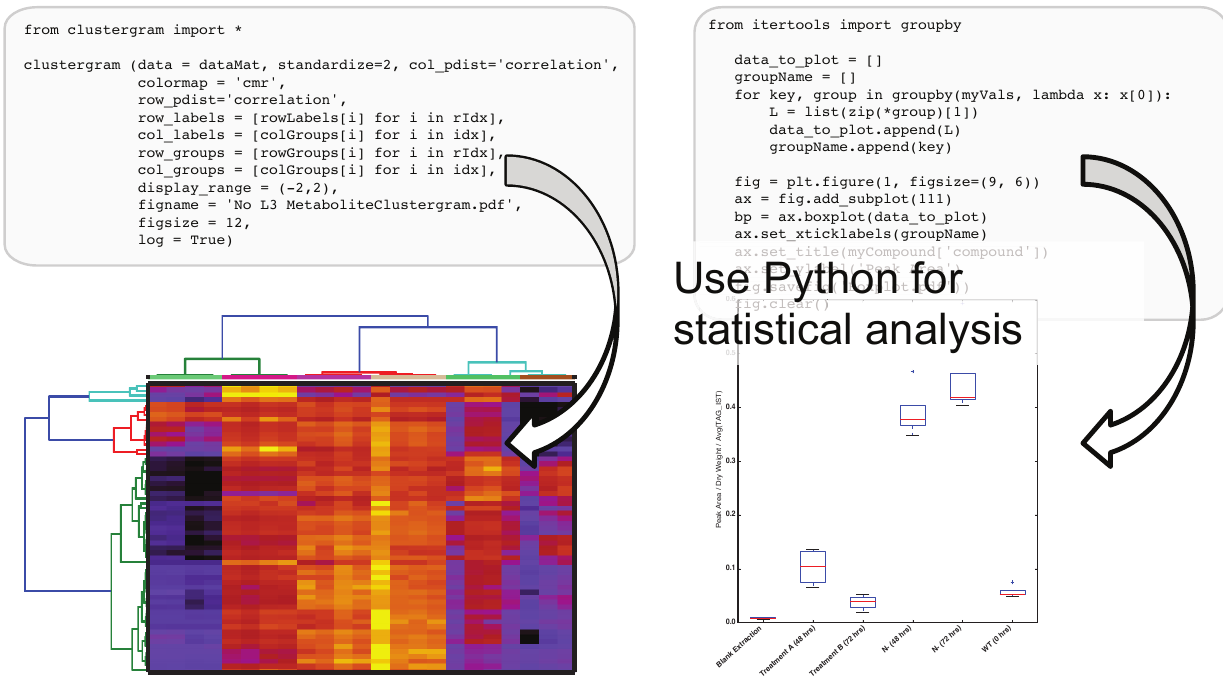
Figure 4. After optimizing the bounds for an Atlas, a user can acquire peak areas from Metabolite Atlas and perform statistical analysis for the compounds detected in their experiment. Python’s scientific libraries for statistical analysis can easily be implemented to perform common analysis such as hierarchical clustering and statistical confidence